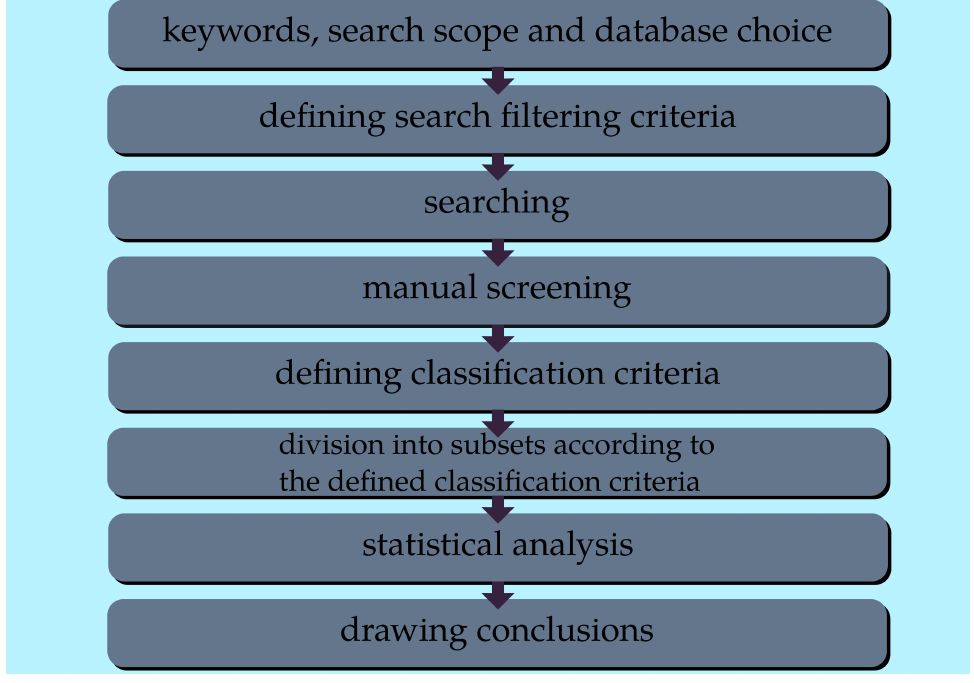
Figure 2. Proposed